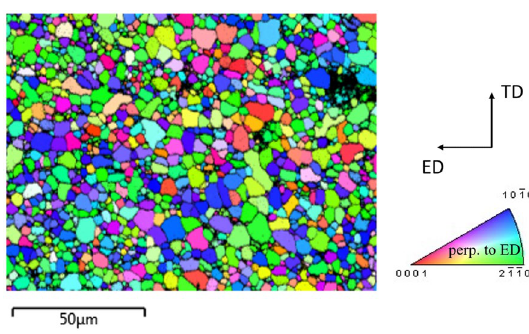
Figure 1. Inverse pole figure (IPF) map showing the initial microstructure of Mg-1.5Nd alloy. The sample direction perpendicular to the maps is perpendicular to ED as indicated in the standard IPF triangle. The colors in the IPF maps represent the orientation of perpendicular to ED sample axis with respect to the crystal lattice frame according to the coloring in the standard IPF